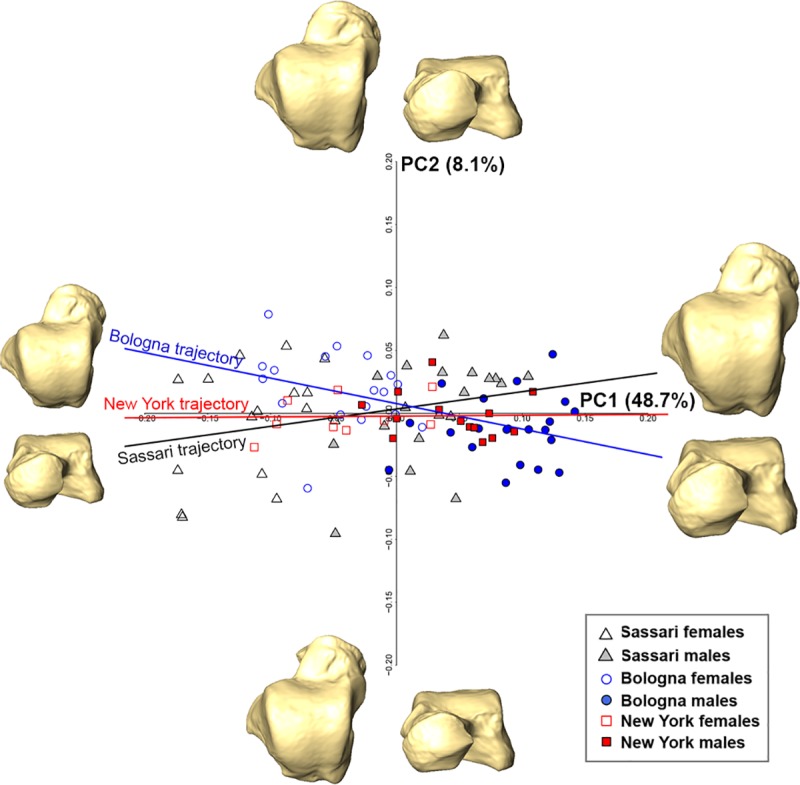
Form space PCA plot of the pooled sample and shape warps along axes.Sassari individuals are in black, Bologna individuals in blue and New York individuals in red. Intragroup allometric trajectory (black for Sassari, blue for Bologna and red for New York) are shown in the PCA plot. The deformed mean tali in the four directions of the PCs are drawn at the extremity of each axis.